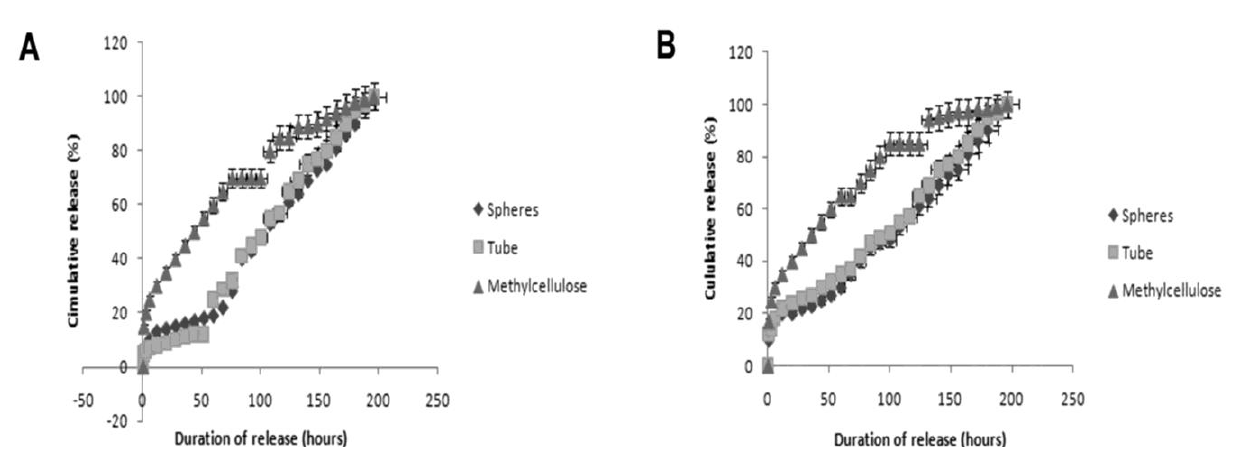
Figure 4. Growth factor release (%) from the various encapsulations indicated over time. (A) FGF-2, (B)